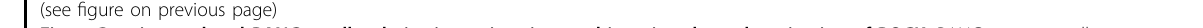
Fig. 4 Gastrin-regulated PANC-1 cell polarization, migration, and invasion through activation of ROCK. PANC-1 cancer cells were pre- incubated with Y27632 reagent, an effective inhibitor of ROCK, for 4 h and were then stimulated with gastrin for 1 h. a Activated paxillin with high levels of phosphorylation at Tyr118 and Tyr31 that were induced by gastrin were signi fi cantly inhibited by Y27632 pre-treatment, while total paxillin was unchanged. b Immuno fl uorescence images indicate an increased polarization of F-actin and aggregation of focal adhesions at the leading edge in gastrin-treated PANC-1 cells. Y27632 pre-treatment obviously blocked the focal adhesion enrichment and cell polarization. Boxed regions represent the area of the merged image used for the zoom; c The mean number of large-sized focal adhesions labeled by paxillin per cell are indicated, and the average number of focal adhesions from a minimum of 20 cells was calculated. d , e The migration and invasion of PANC-1 cells pre-treated with Y27632 were investigated by scratched wound healing ( d ) and the Boyden invasion assay ( e ). Values indicate the means ± SD from three independent experiments. * P <